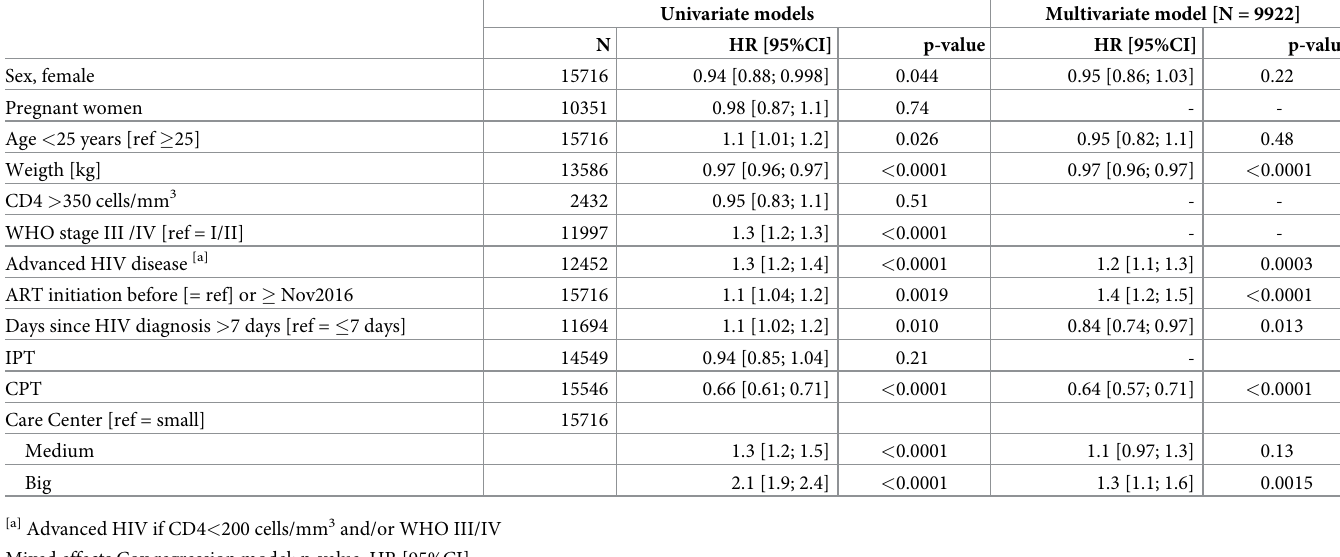
Table 2. Characteristics associated with retention: Mixed effects Cox regression models on probability of death or LTFU for the entire cohort.